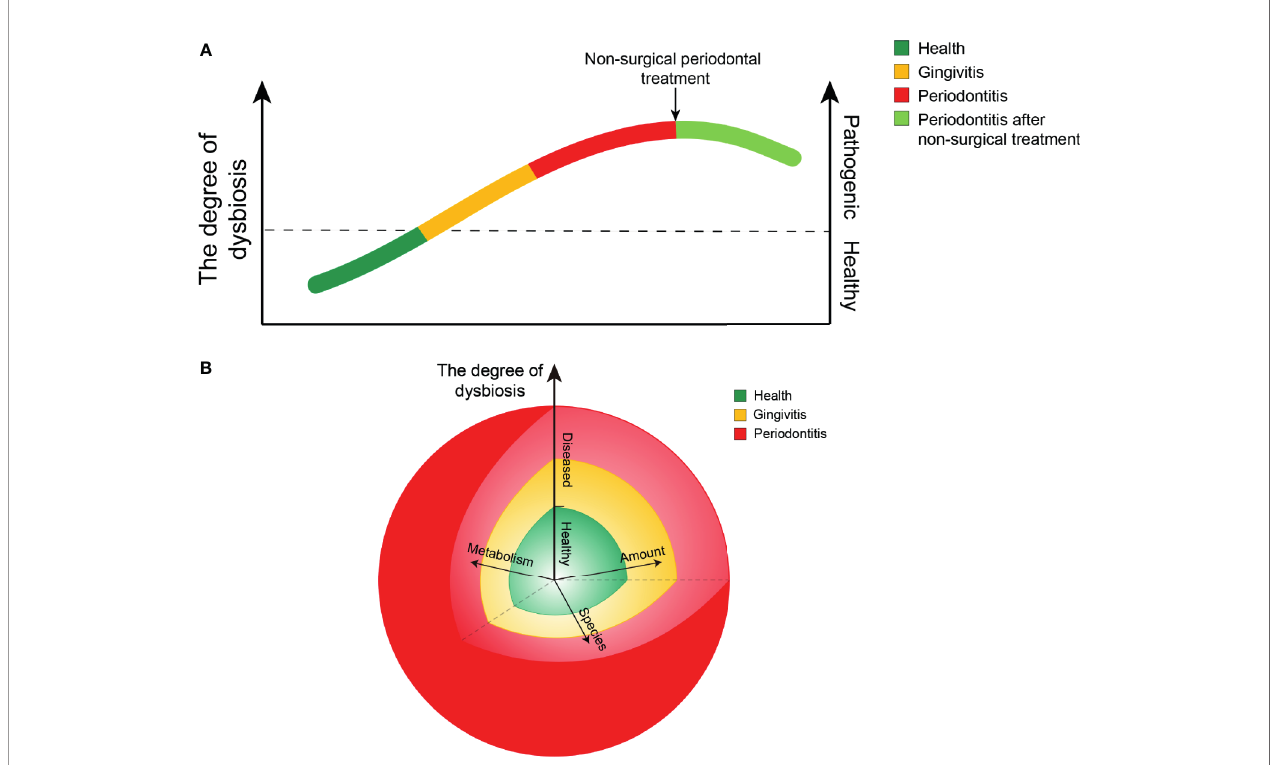
FIGURE 6 | Diagrams of the ecological plaque hypothesis in periodontal disease. (A) Chart showing changing trends in the degree of dysbiosis from healthy to diseased and after nonsurgical treatment of periodontitis. (B) Chart showing changing trends in the degree of dysbiosis resulting from the combined action of three factors: the amount of bacteria, the species composition, and their metabolic function. The length of the arrows represents their respective in fl uence. The angle between any two of the arrows represents an interaction between the factors, while the interaction is not yet well